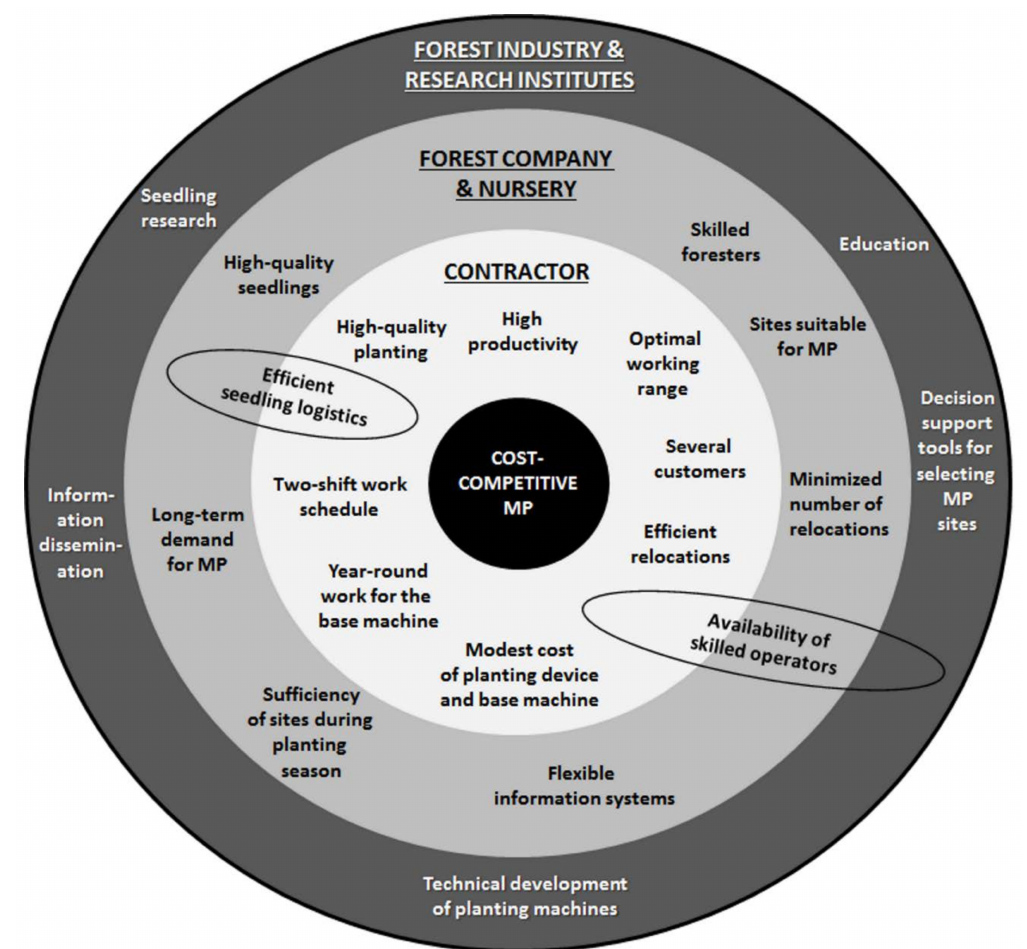
Figure 1. A conceptual framework showing the factors leading to cost-competitive mechanized tree planting (MP) in both Sweden and Finland. The factors in the outer darker ring are those chiefly shaped by the forest industry as a whole and by research institutes. The factors in the middle grey ring are those influenced by the forest company and the nursery supplying the seedlings. The factors in the inner white ring are those mainly affected by the planting machine contractor. The two encircled factors (efficient seedling logistics and availability of skilled operators) are influenced by two or three actors (contractor plus nursery, and contractor, forest company plus whole forest industry, respectively). Modified from reference